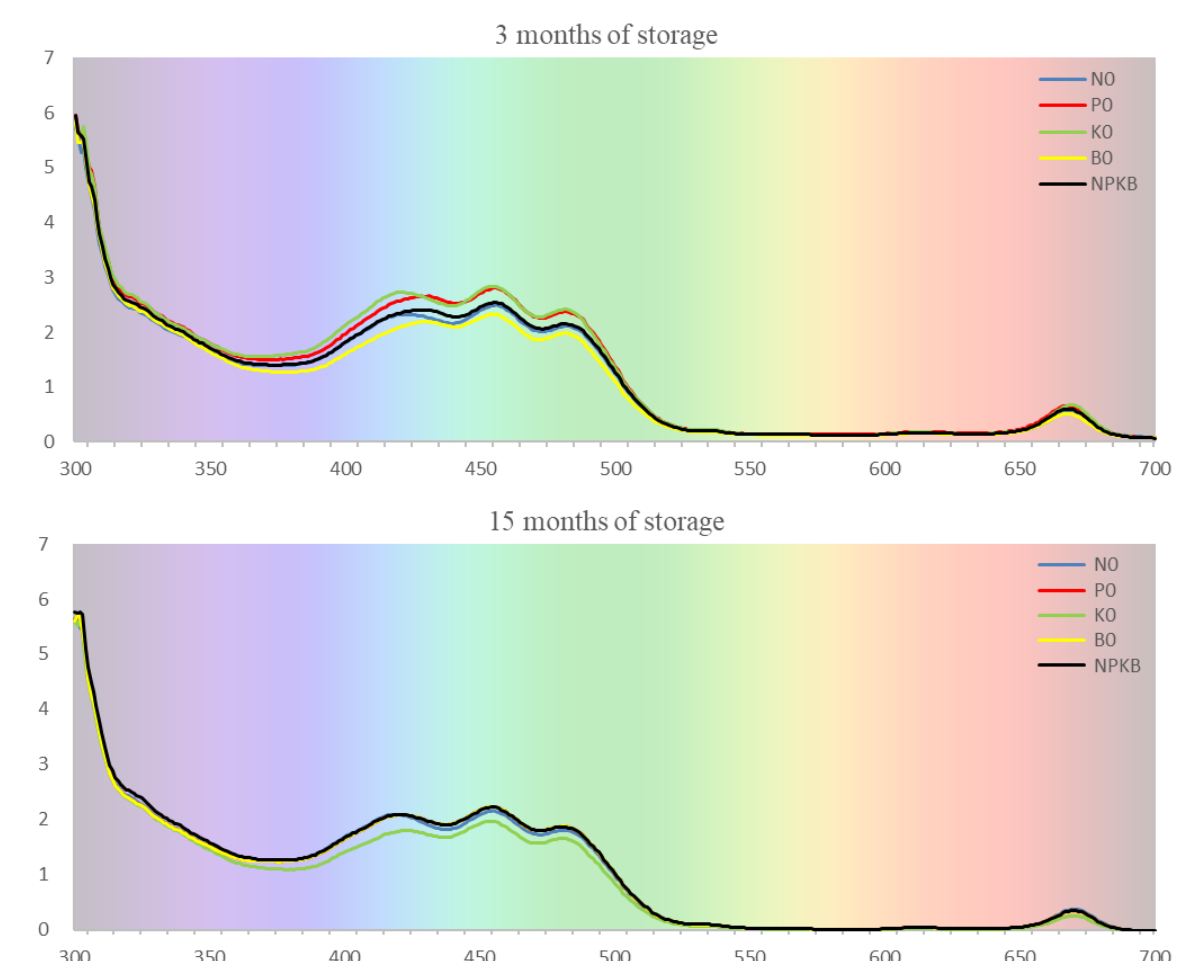
Figure 4. Absorption spectra from olive oil after 3 and 15 months of storage from olive trees supplied with NPKB (control) and without N (N0), P (P0), K (K0) and B (B0) in the harvest of 2018.